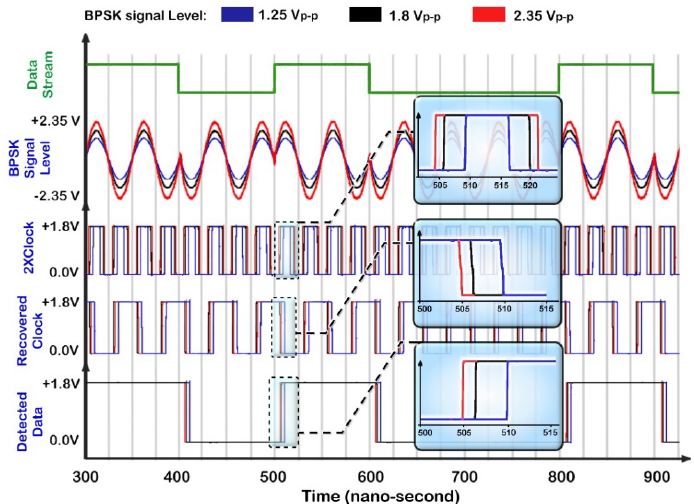
Figure 11. Demodulated data and the recovered clock with ± 30% variations on received BPSK signal